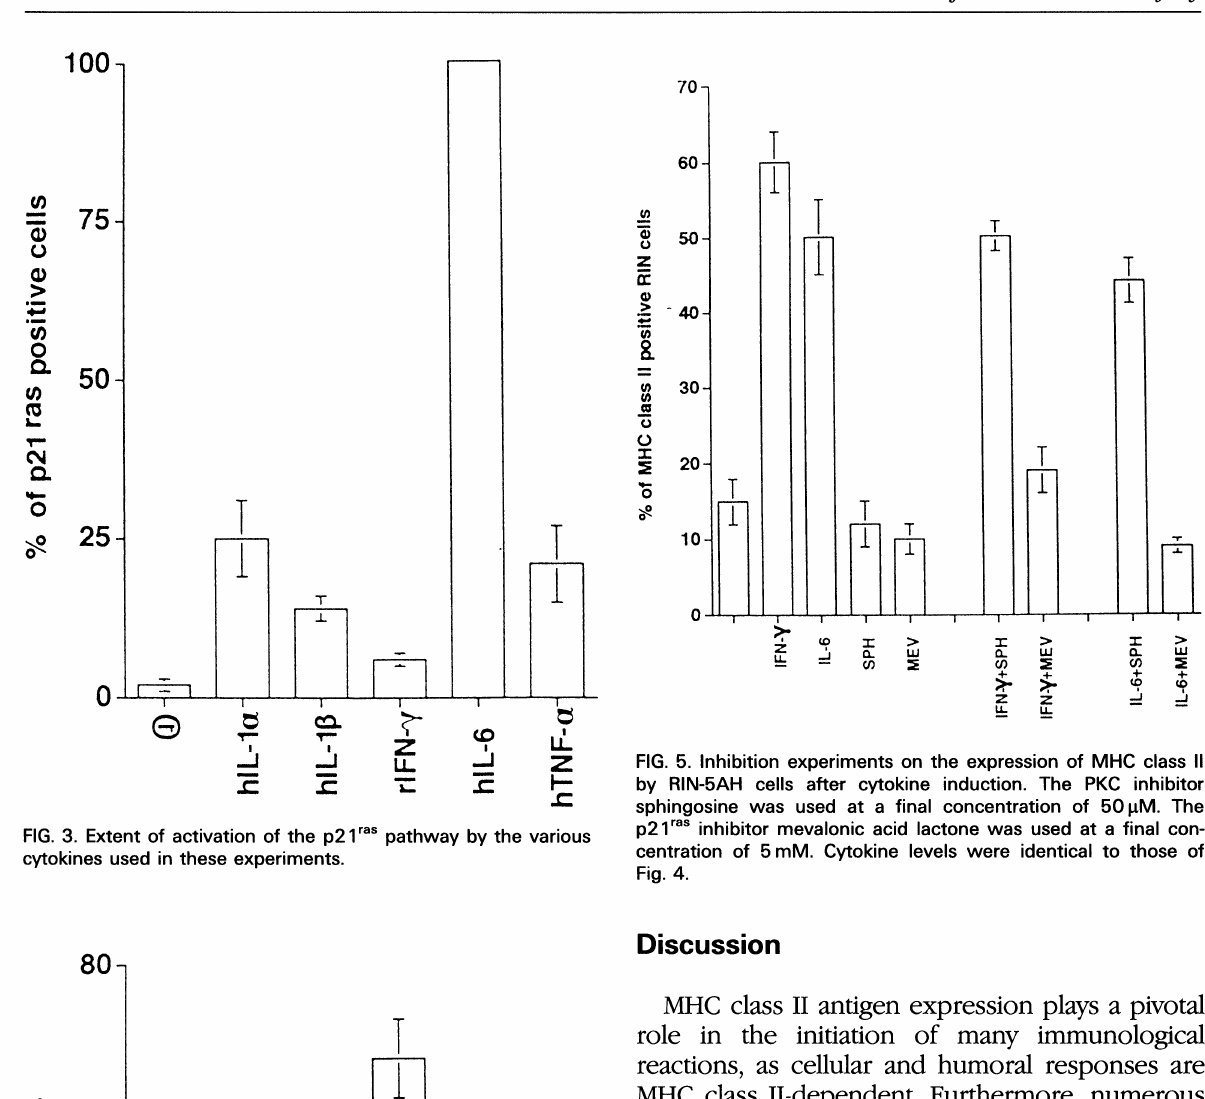
FIG. 5. Inhibition experiments on the expression of MHC class II by RIN-5AH cells after cytokine induction. The PKC inhibitor sphingosine was used at a final concentration of 501M. The p21